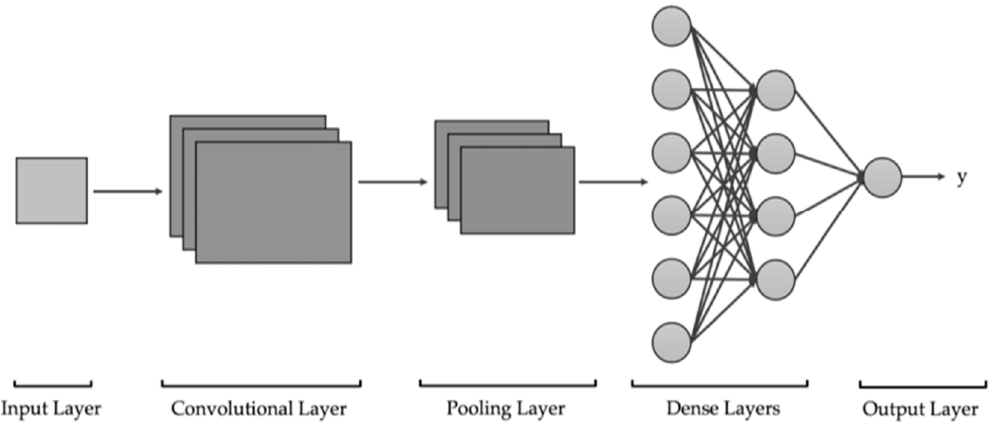
Figure 2. Standard CNN.